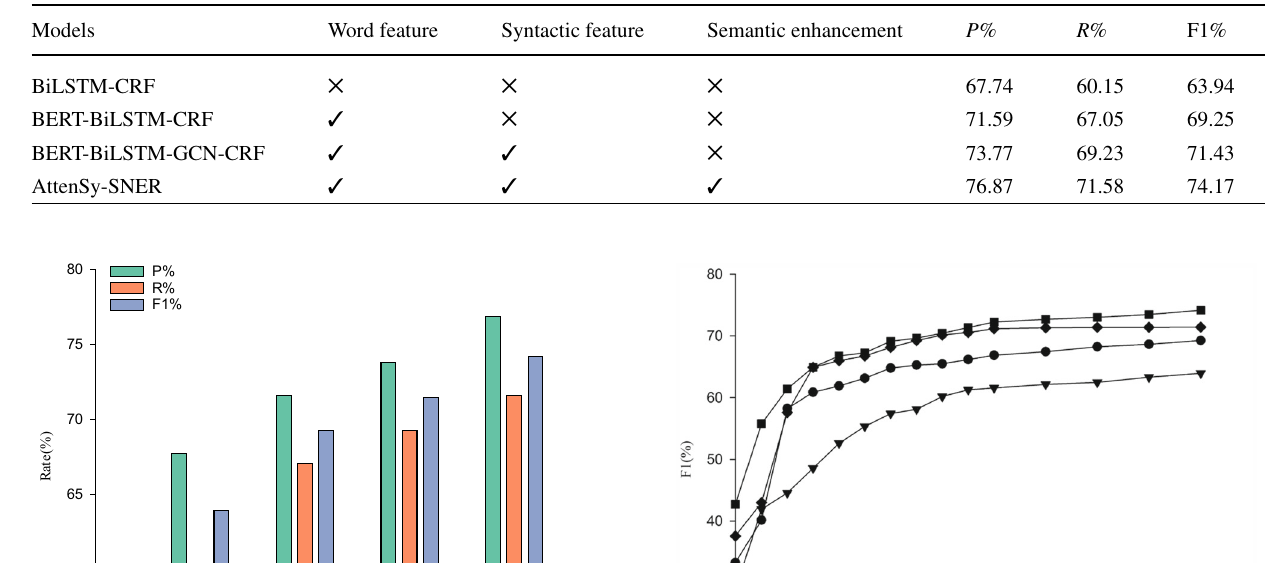
Table 7 Contribution of semantic enhancement to model performance